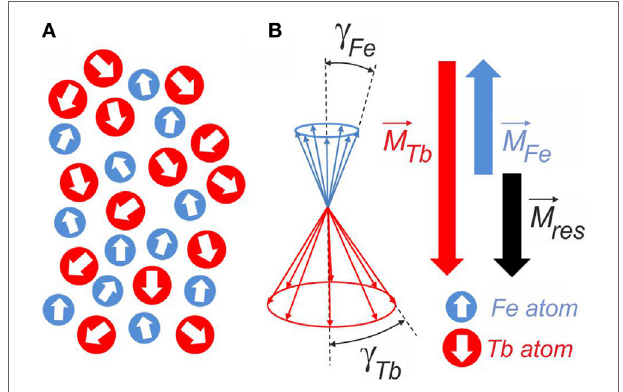
FigUre 1 | (a) Magnetic moment distribution in an amorphous Tb-Fe material with two preferred antiparallelly oriented magnetic sublattices. (B) Averaged distribution of the magnetic moments